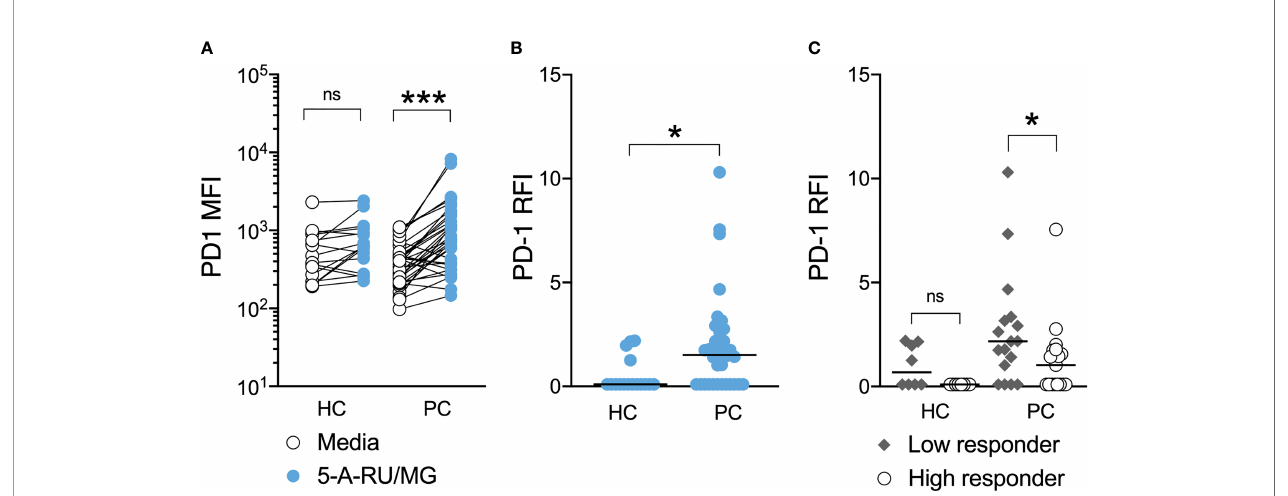
FIGURE 5 | PD-1 upregulation is associated with impaired MAIT-cell proliferation in men with prostate cancer. At the end of 7-day culture in the above proliferation assay, the surface expression of PD-1 on stimulated and unstimulated MAIT-cells was compared (A) and the relative fl uorescence intensity calculated (B) for healthy controls and men with prostate cancer. Participants were strati fi ed into high and low responders according to the median MAIT-cell fold change for their respective groups and the PD-1 RFI compared (C) . Mann-Whitney test. N = 20 healthy controls, 36 men with prostate cancer. ns, no signi fi cance. *P < 0.05. ***P <